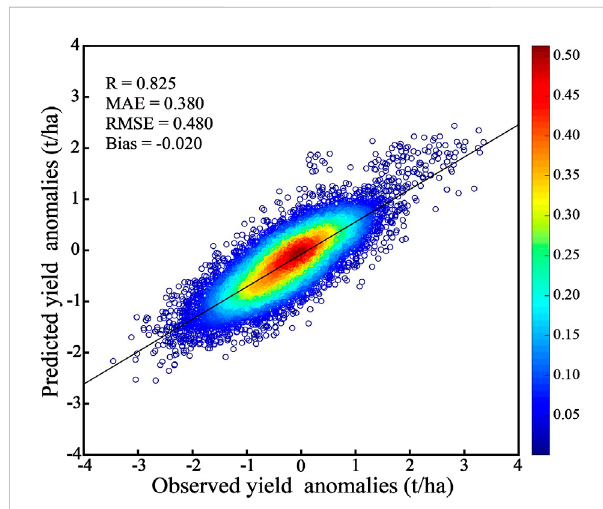
FIGURE 2 Scattered density of yield anomalies between estimated and actual yield anomalies. We drew the scatter density plot of estimated and actual yield anomalies and calculated the fi tting coef fi cient. R is 0.825, MAE is 0.38, RMSE is 0.48, and the Bias is − 0.02. All deviations are measured in tons per